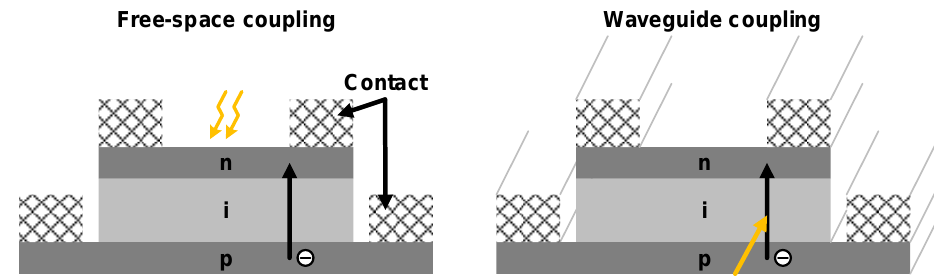
Figure 20. Categorization of PD by coupling schemes.